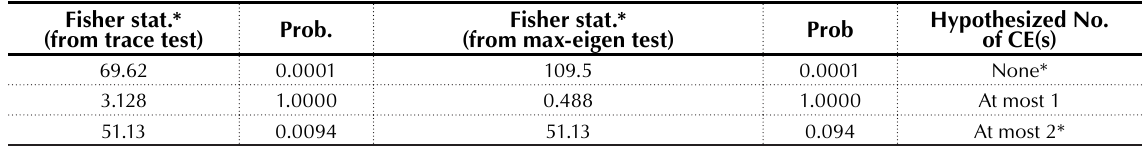
Source: researcher’s computation